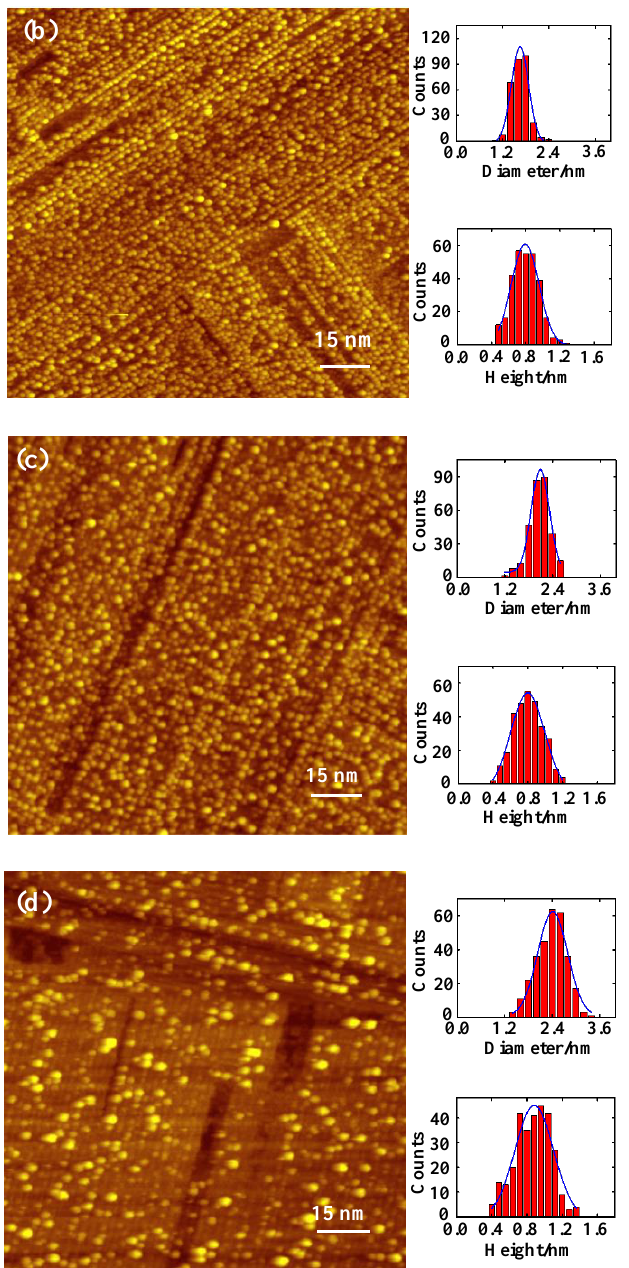
Figure 2. STM images for 1.35-MLe Rh deposited on a thin film of Al 2 O 3 / NiAl(100) at ( a ) 300 K and annealed stepwise to ( b ) 450, ( c ) 570 and ( d ) 800 K. The insets in ( a – d ) show characteristic histograms of height and diameter for each temperature; the curves are the best Gaussian fits to the distributions.